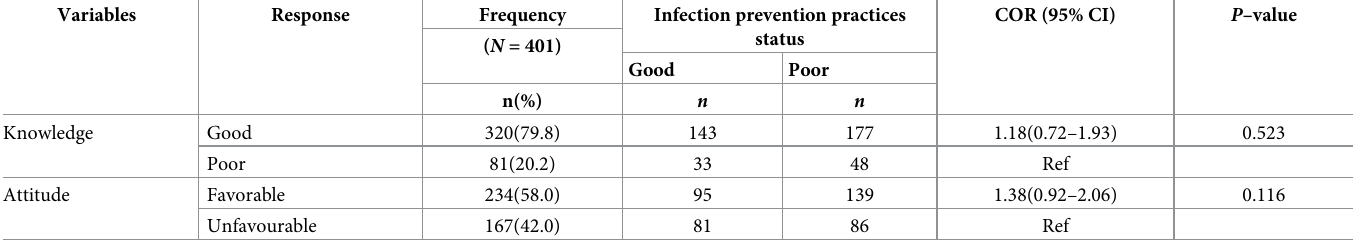
Table 3. Knowledge and attitude of food handlers and bivariable analysis with infection prevention practices among food handlers at food and drink establishments in Dessie City and Kombolcha Town, Northeastern Ethiopia, July–August